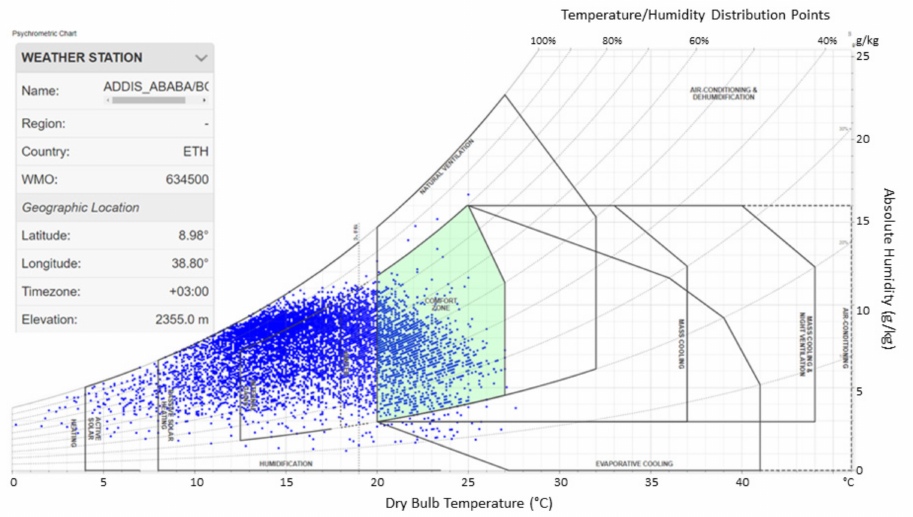
Figure 12. Hourly psychometric chart with Givoni Bioclimatic Chart overlay, Addis Ababa,